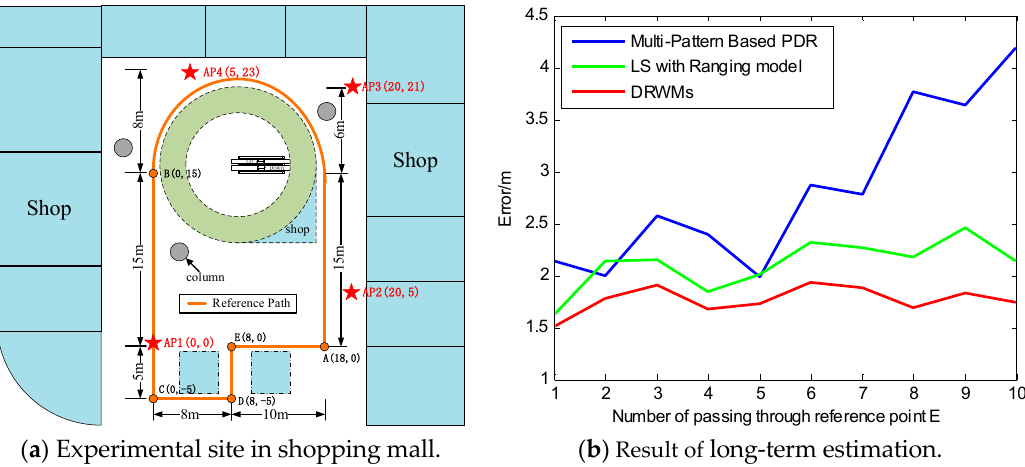
( b ) Result of long-term estimation. Figure 16. Long-term estimation in second experimental site. Figure 16. Long-term estimation in second experimental